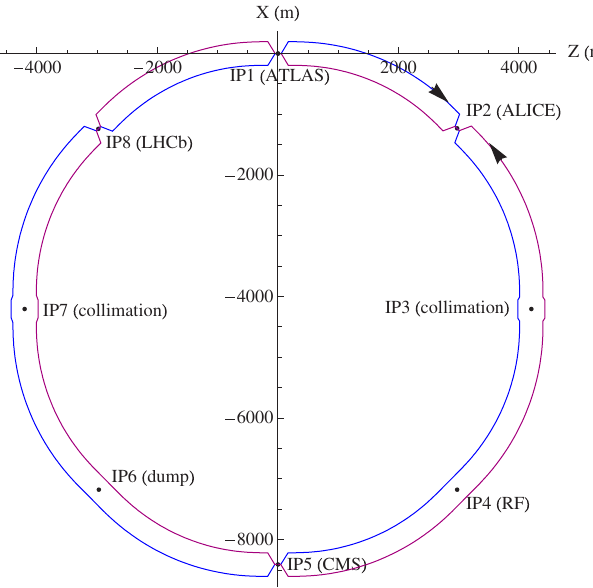
FIG. 1. (Color) The schematic layout of the LHC (the separation of the two rings is